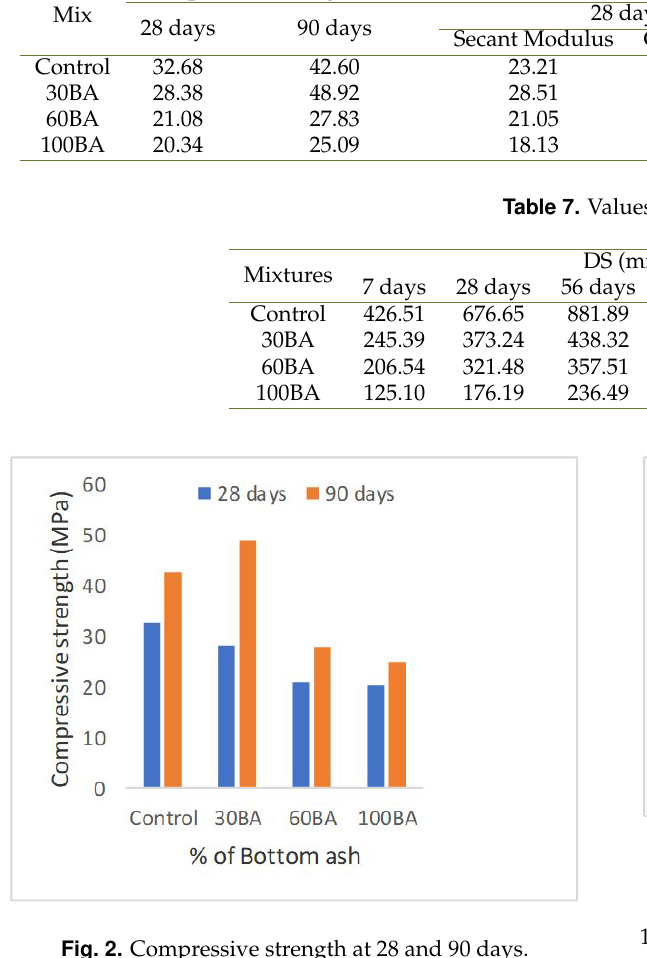
Fig. 2. Compressive strength at 28 and 90 days.